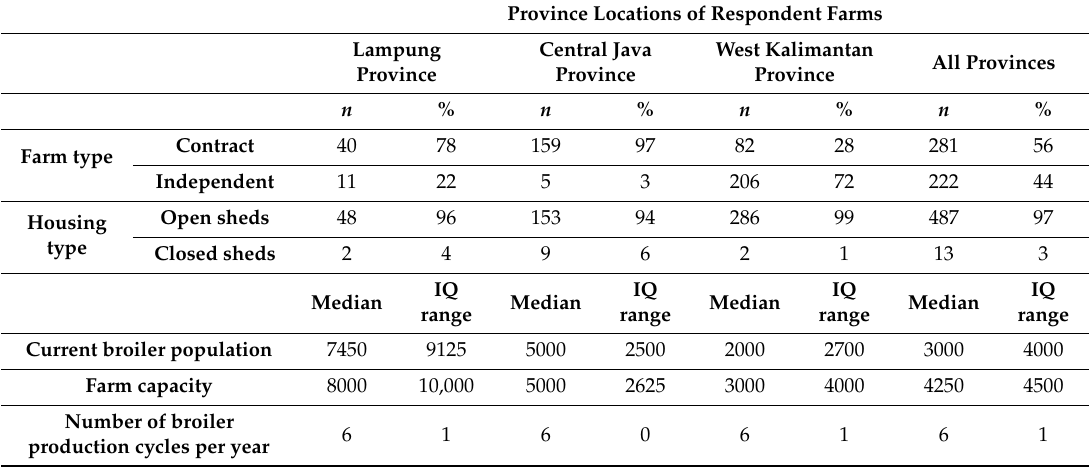
Table 2. Demographic information on the respondent